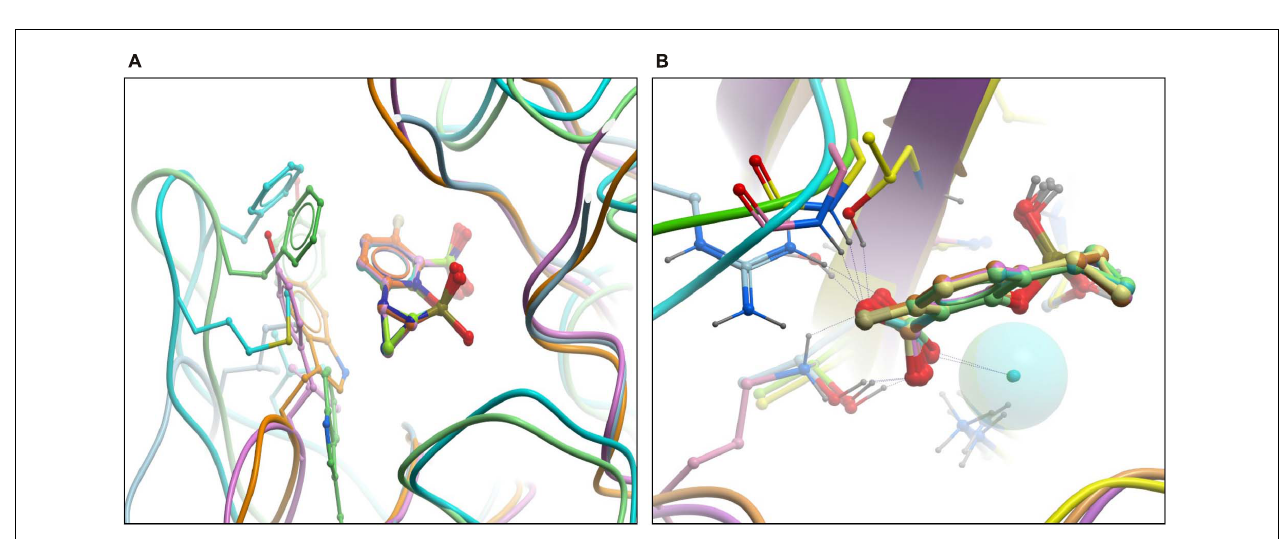
FIGURE 2 | High resolution structures of QPX7728 with KPC-2, OXA-48, NDM-1, and VIM-2. Accession codes are the following: 6V1J (KPC-2: QPX7728), 6V1M (NDM-1: QPX7728), 6V1O (OXA-48: QPX7728), and 6V1P (VIM-2: QPX7728). Modified from Hecker et al. (2020).